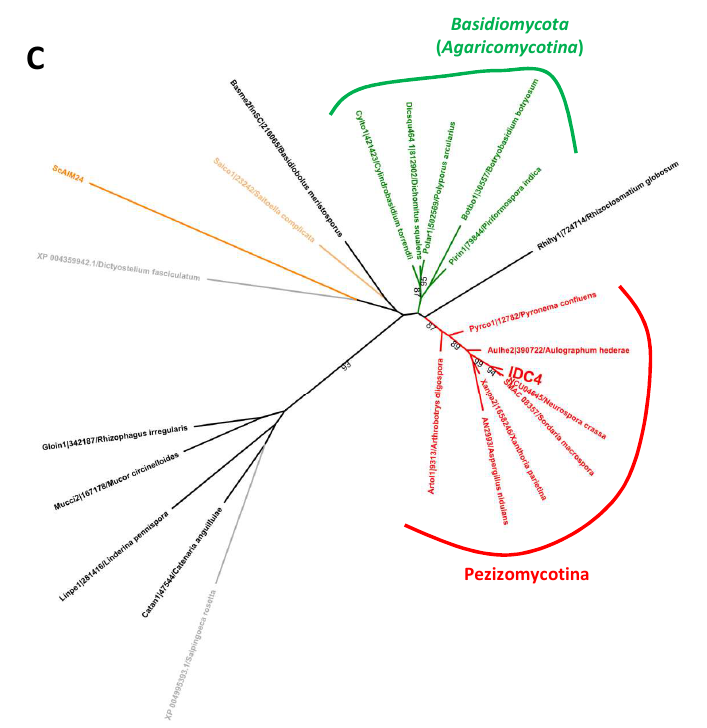
Figure 5. ( A ) Structure of the IDC4 gene: red boxes are exons. ( B ) Structure of the IDC4 protein. The AIM24 domain is underlined. The prolines are in red and the glutamines in blue. The position of the glutamine codon changed into a stop codon in IDC 508 is boxed. ( C ) Phylogenetic tree constructed with selected IDC4 paralogues and/or